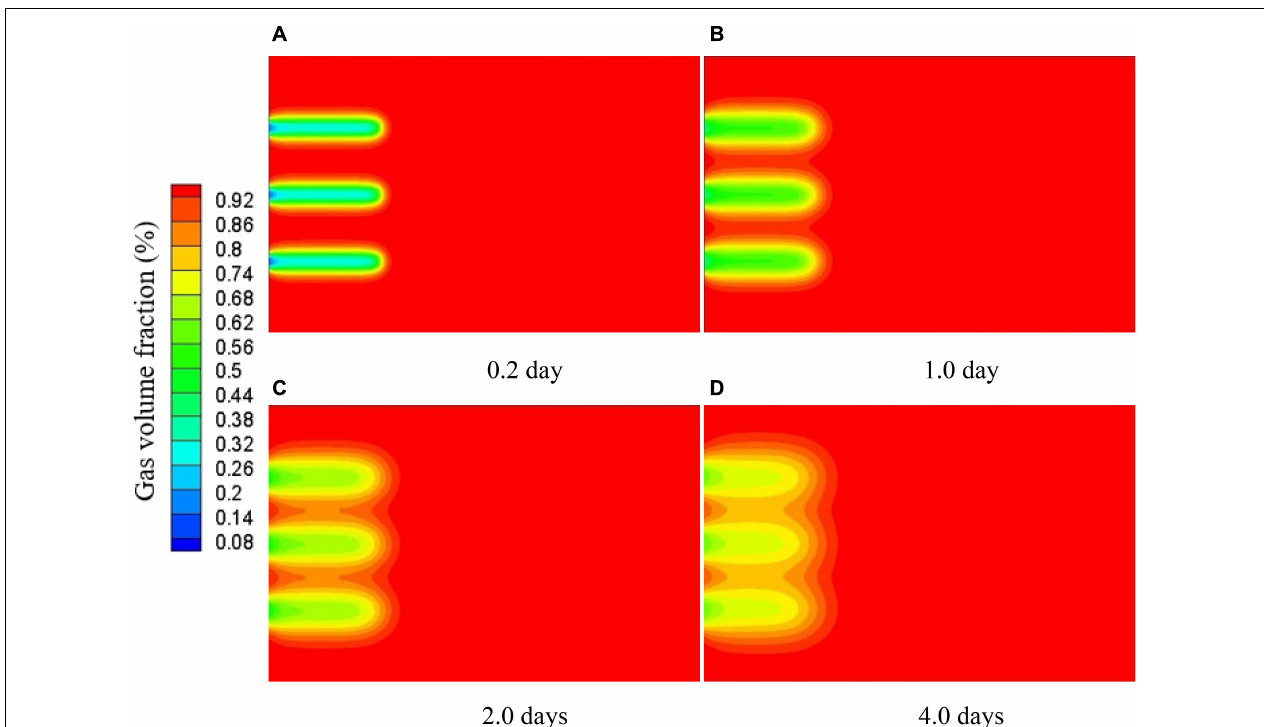
FIGURE 8 | Gas seepage fields of a 3-m slotted coal seam when λ = 1: (A) 2 day, (B) 1 day, (C) 2 days, and (D) 4 days.